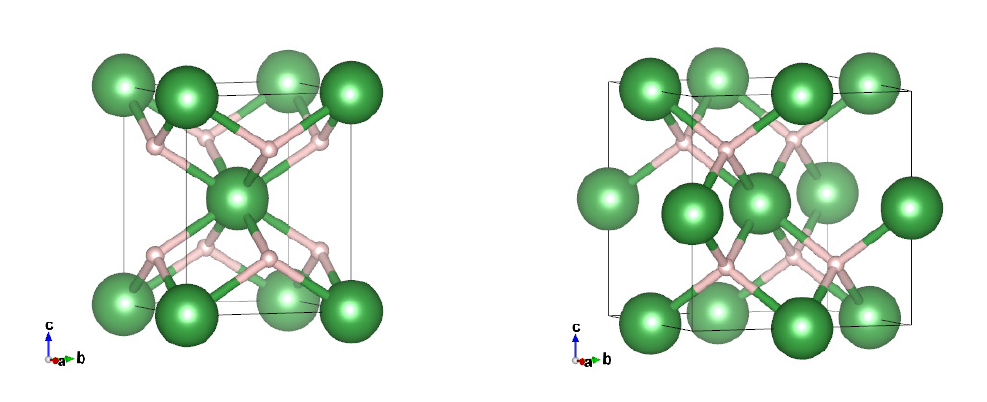
Figure 1. Crystal unit cell for (cid:101) -ZrH 2 ( left ) and δ -ZrH 1.5 ( right ). Zirconium atoms are colored green (large) and hydrogen atoms are rose